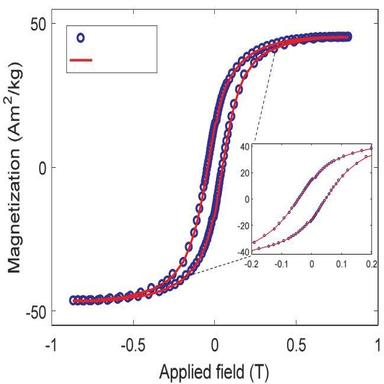
Measurements of NiFe2O4 particles using two different sensitivities. Comparison of the magnetization of fine Ni particles obtained with our magnetometer using the current cylinder model (circles) with the results obtained using the same particles and the Hall magnetometer (solid curve). The inset shows the zero-field region.